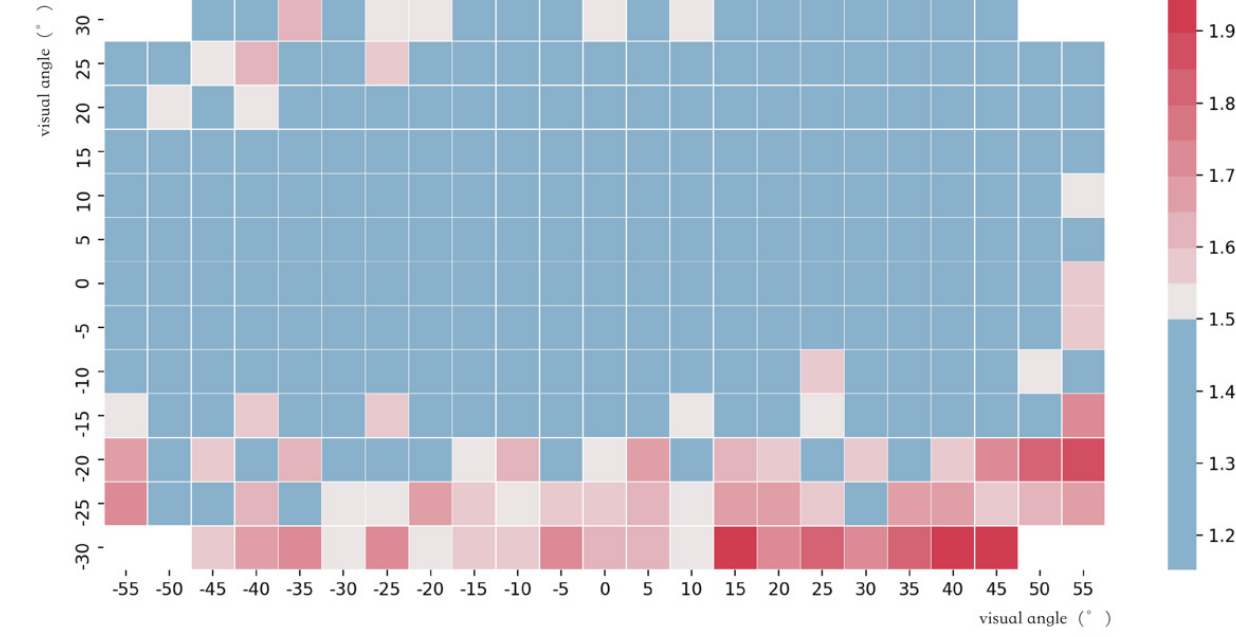
Figure 6. Heat map of click accuracy.